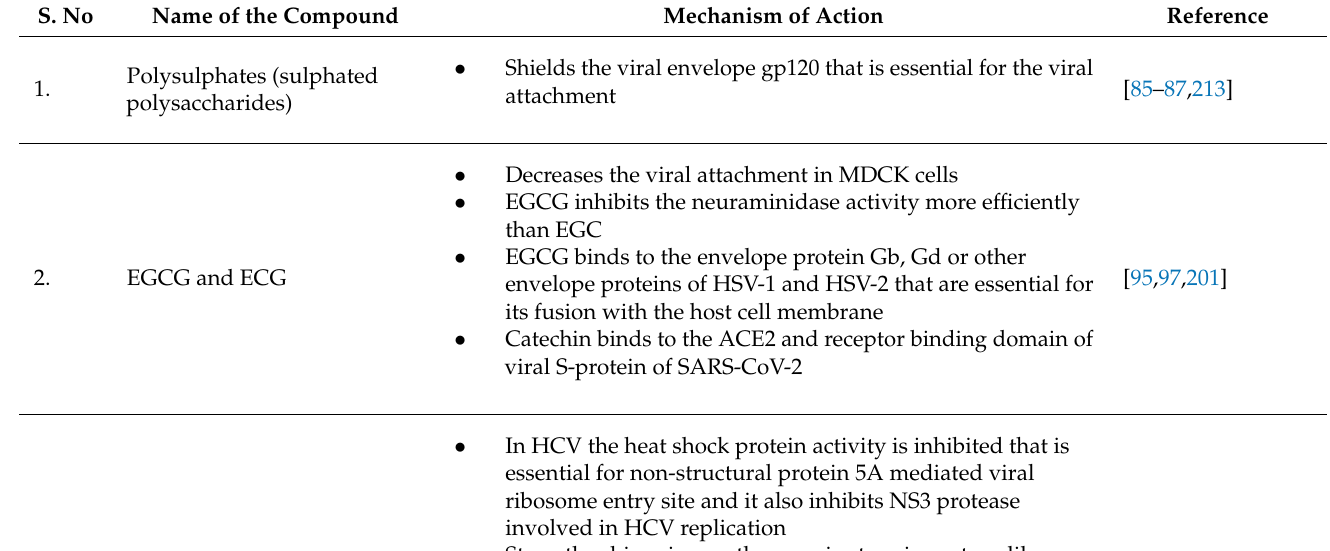
Table 3. Mechanism of antiviral action of phytochemical compounds and its derivatives. S.